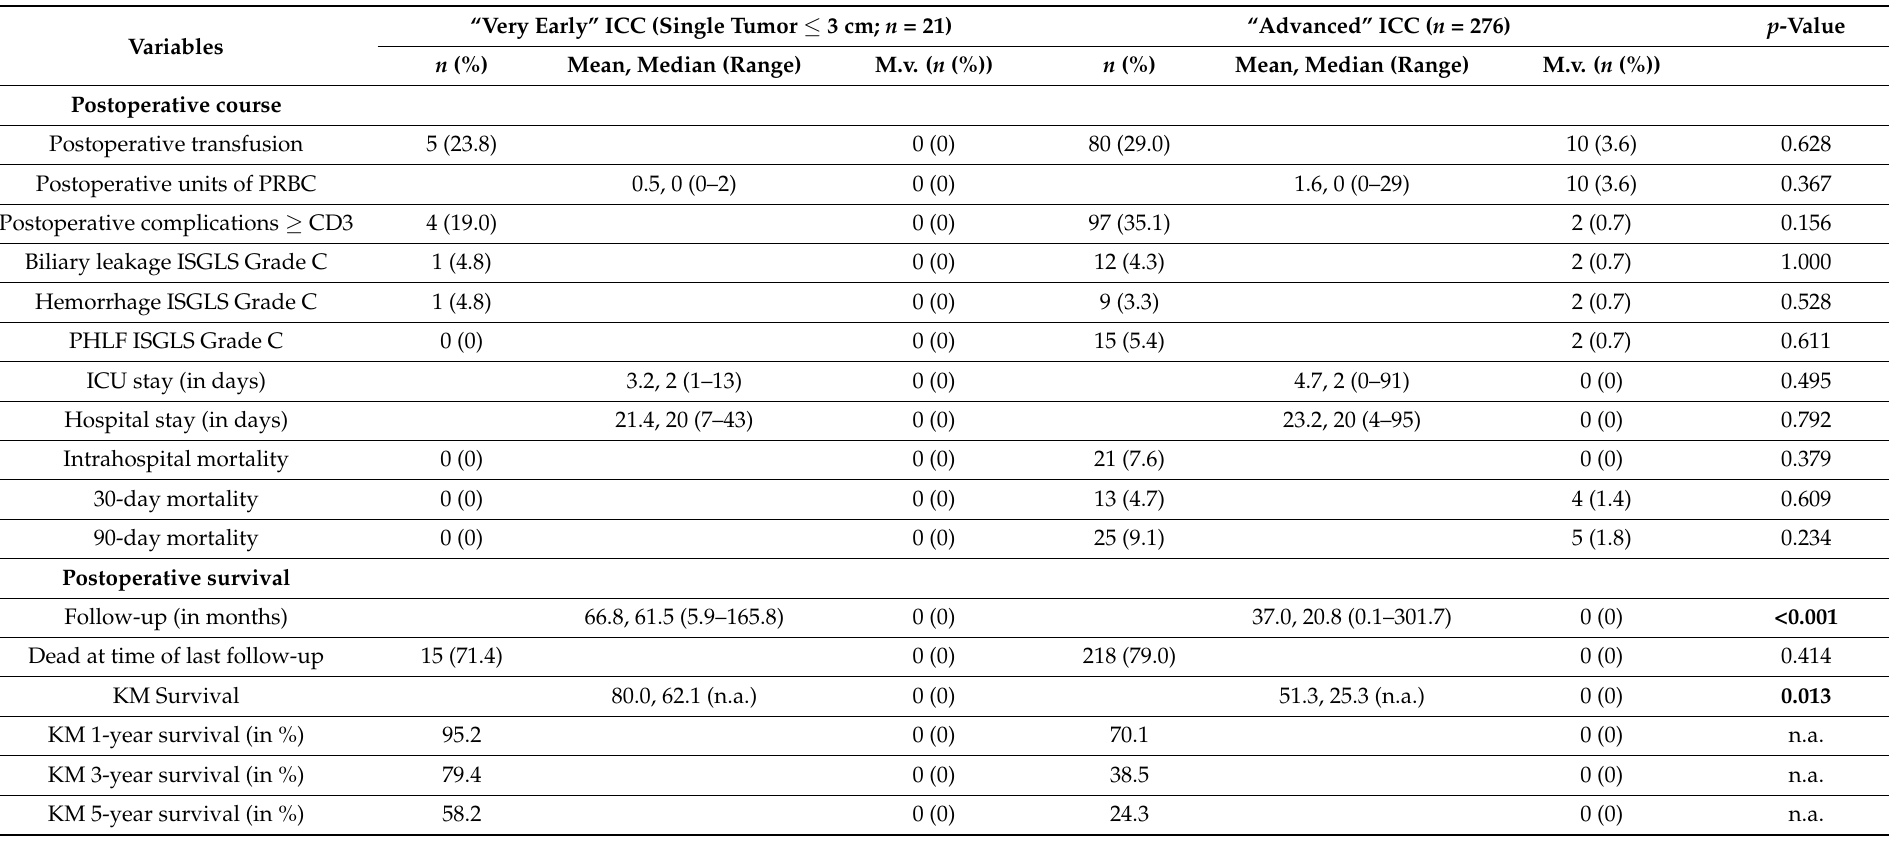
Table 3. Postoperative course and survival of patients with “very early” intrahepatic cholangiocarcinoma (ICC) including a comparison to a control group undergoing resection with curative